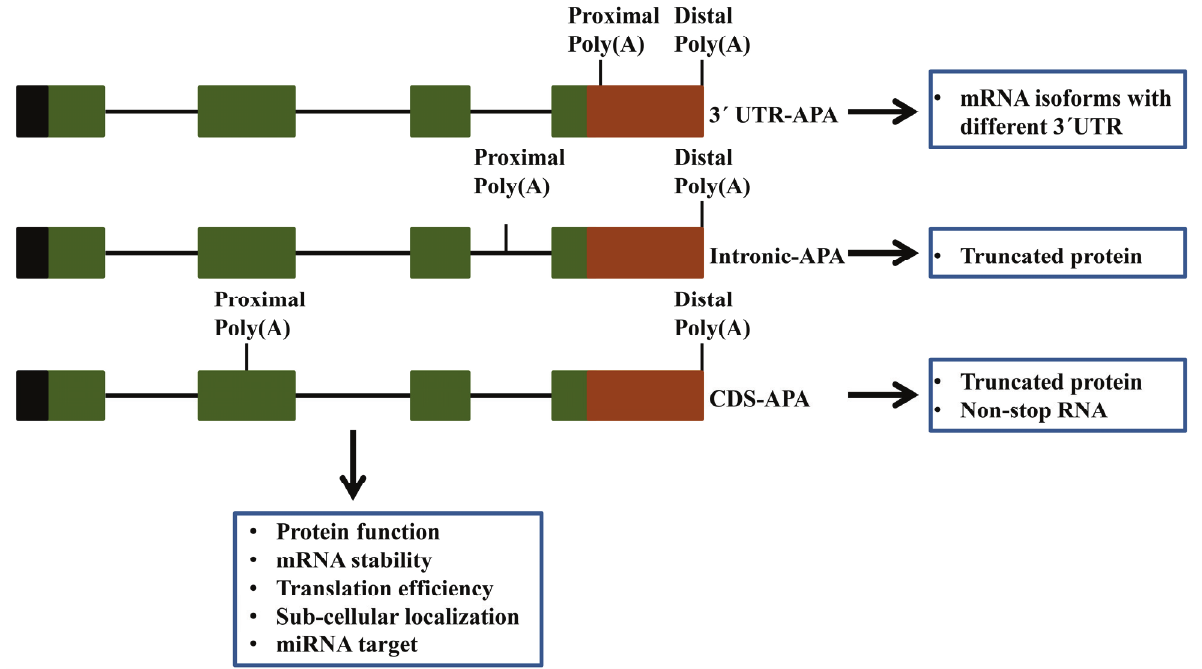
Figure 1. Different types of alternative polyadenylation and their possible consequences on gene expression. A hypothetical gene with four exons is used for schematic representation of different kinds of APA. Exons, 5' UTRs and 3' UTRs are represented with green, black and brown boxes, respectively, while introns are depicted with black horizontal lines. Proximal and distal poly(A) sites are shown with black vertical